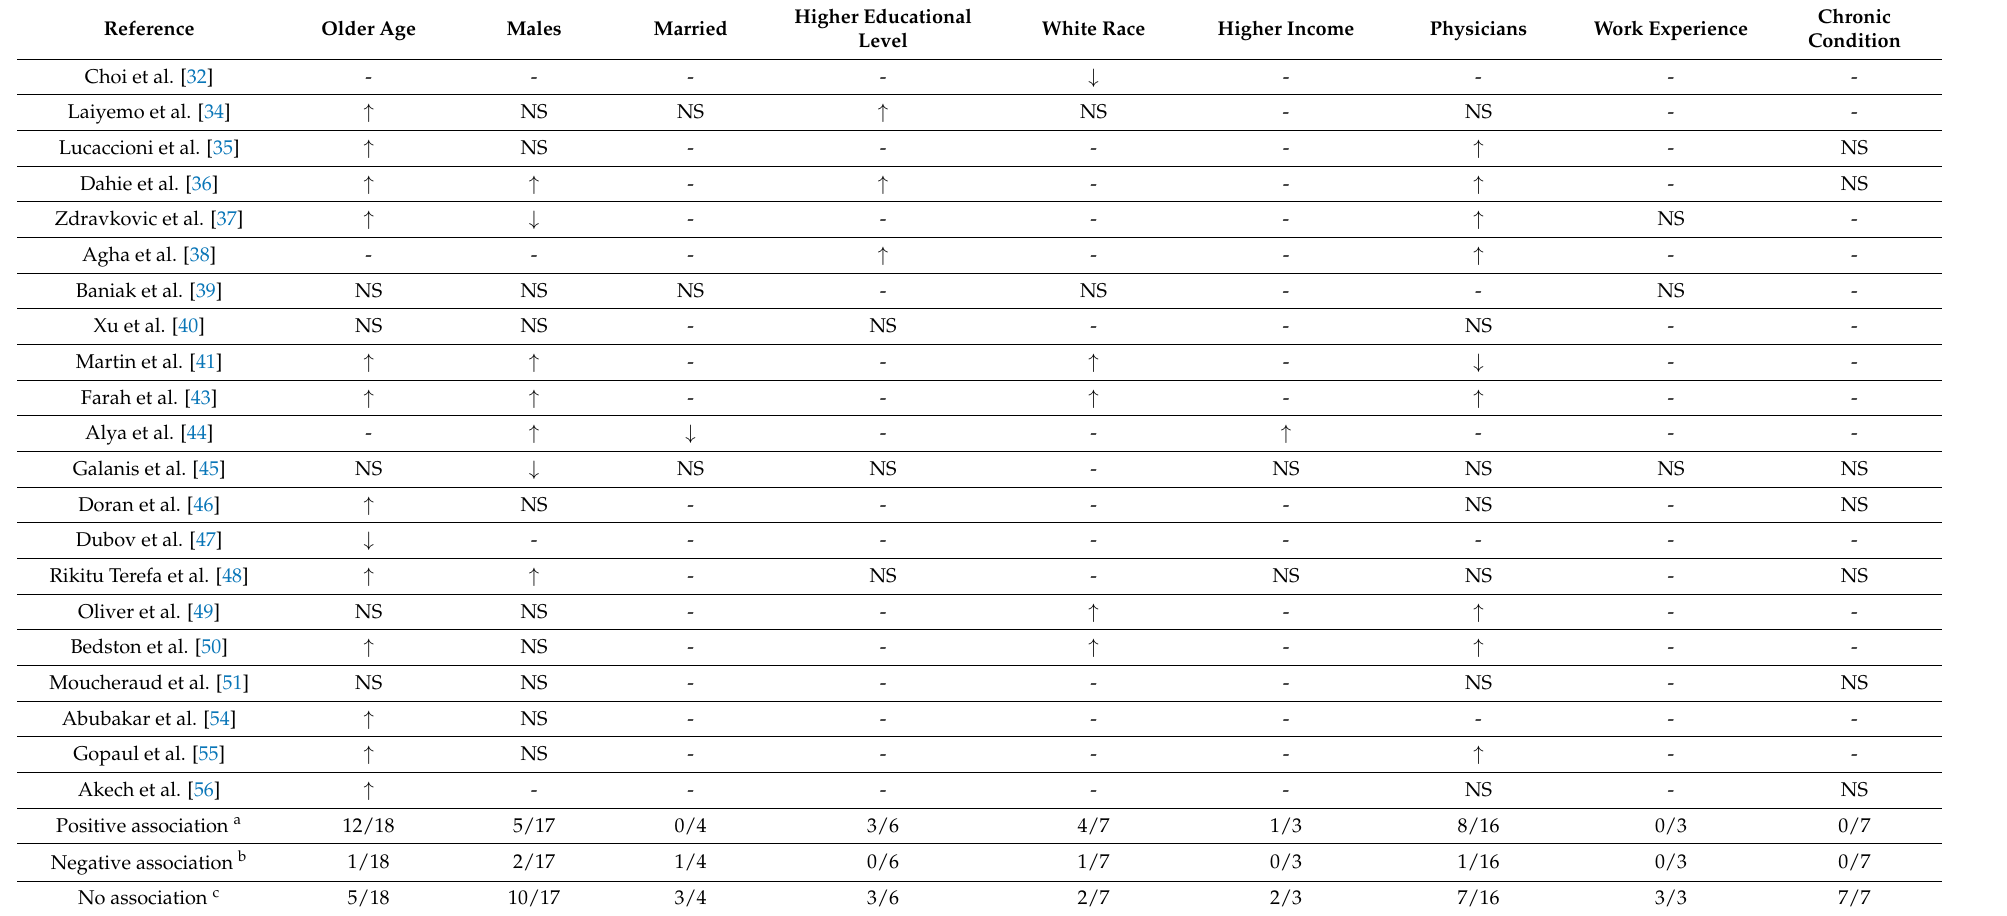
Table 1. Predictors of COVID-19 vaccine uptake among healthcare